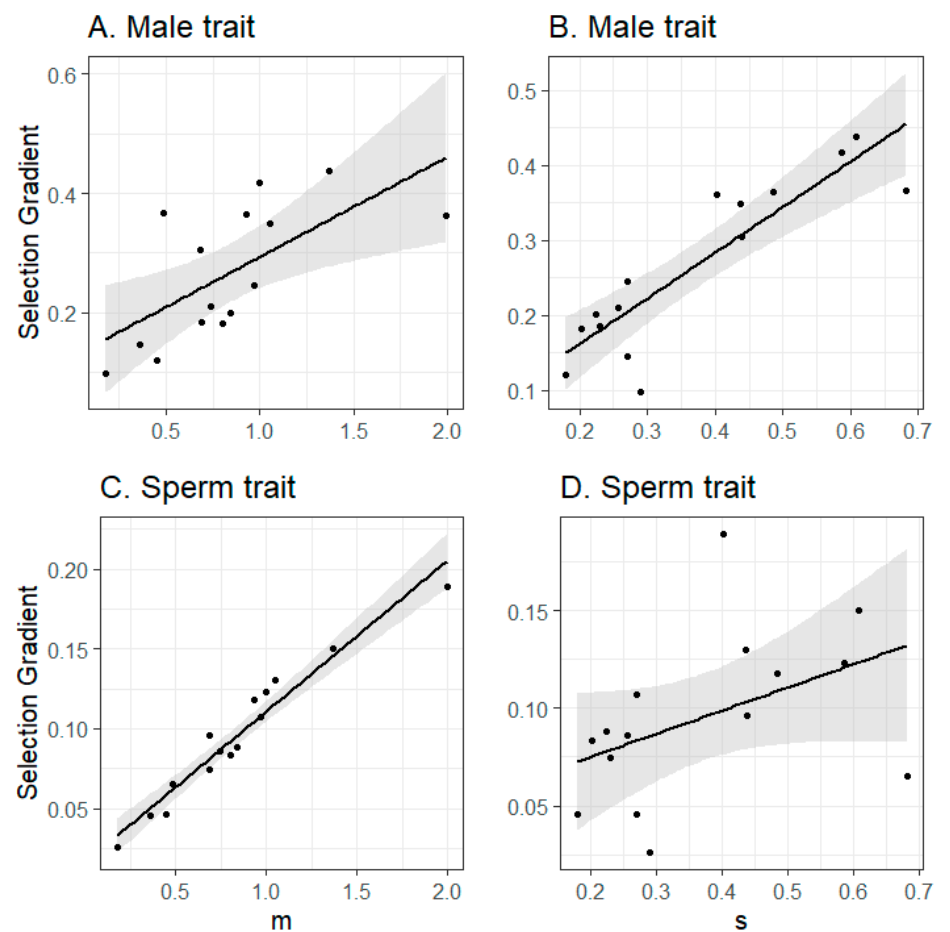
Figure 4. The strength of direct selection on male traits (top row ( A , B )) or sperm traits (bottom row ( C , D )) depending on the species’ value of m (left column; Poisson-distributed mean number of extra-pair copulation partners) and s (right column; variable affecting the likelihood that an extra-pair copulation results in fertilization). Shaded areas represent 95% confidence interval. Direct selection strength was estimated as the mean value from the multivariate selection analysis from populations where both traits were under selection, across all levels of male trait vs. sperm trait correlation. Raw values are presented; statistical tests controlled for phylogenetic relatedness.